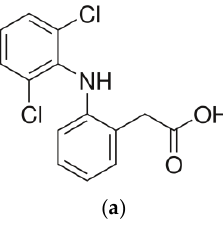
Figure 1. Molecular structure of ( a ) diclofenac, ( b ) sulfamethoxazole and ( c ) trimethoprim. DCF is a non-steroidal anti-inflammatory drug (NSAID) used to treat pain and in- flammatory disorders. Banned in many countries of Southeast Asia [24], DCF was selected